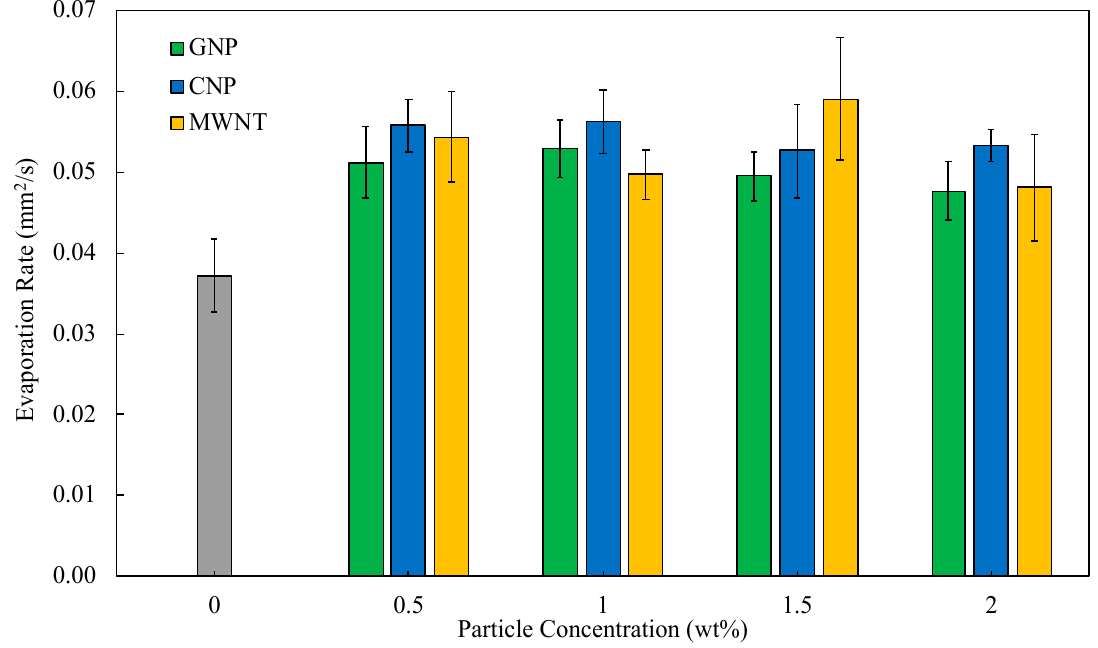
Figure 6. Variation of evaporation rate as a function of particle concentration.